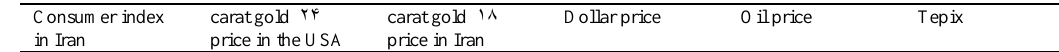
Table 1. The factors used in the previous studies.